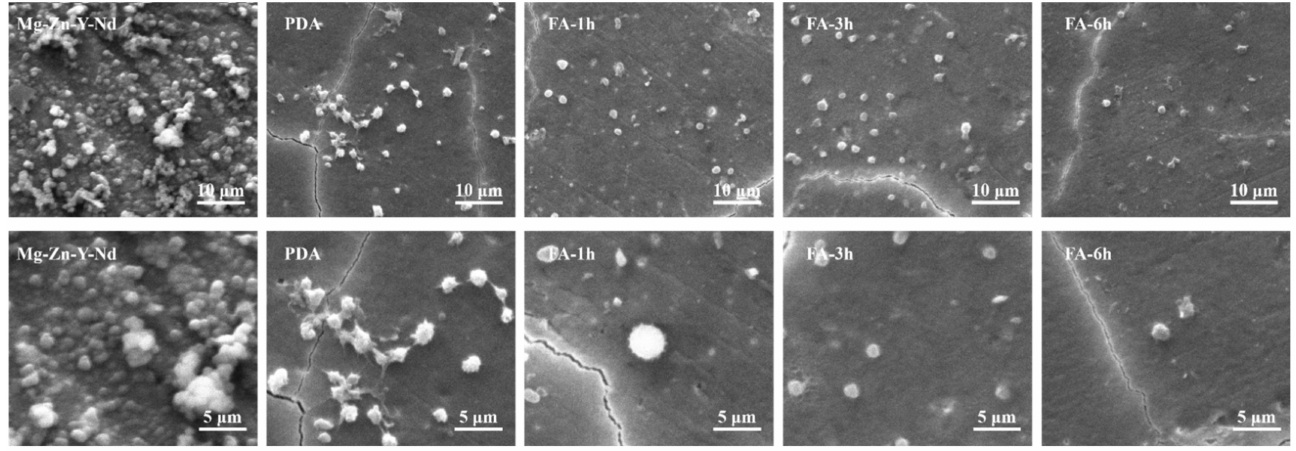
Figure 11. Platelet adhesion morphology of each